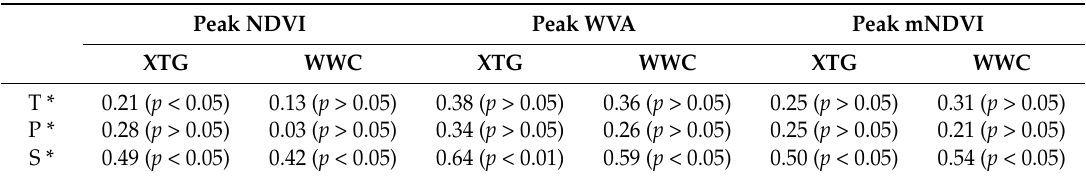
Table 5. The correlation coefficients (r) between the wetland vegetation characteristics at the XTG and WWC and the climatic variables during 1999–2016. Peak NDVI Peak WVA